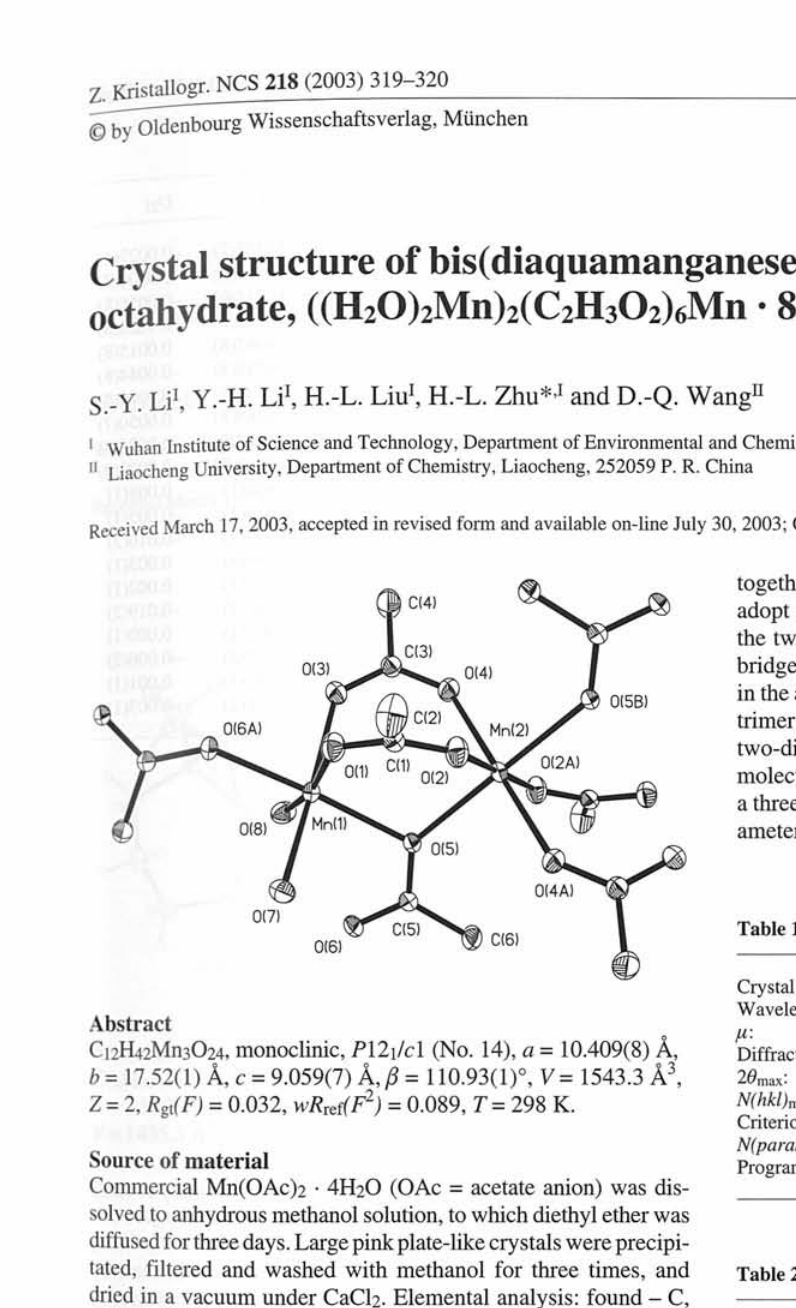
Table 2. Atomic coordinates and displacement parameters (in